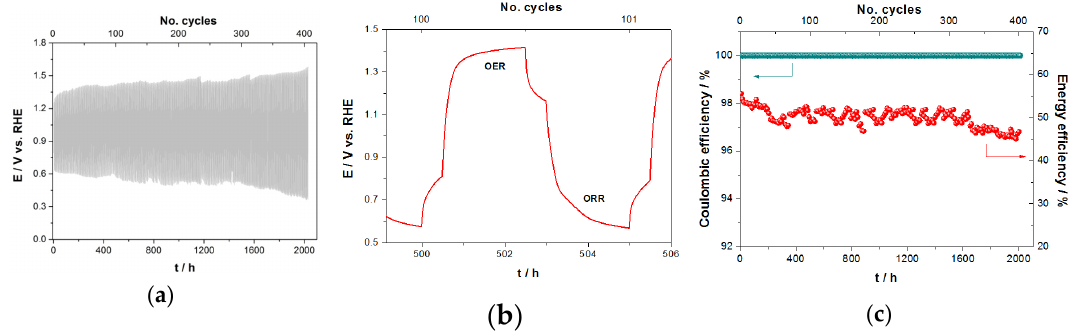
Figure 9. ( a ) Stationary current polarization characteristics of MCO GDE for ORR/OER as a function of time in ChAcO + 30 wt.% H 2 O electrolyte at 100 µA cm − 2 with dry synthetic air. ( b ) 100th cycle and ( c ) corresponding energy and coulombic efficiency.